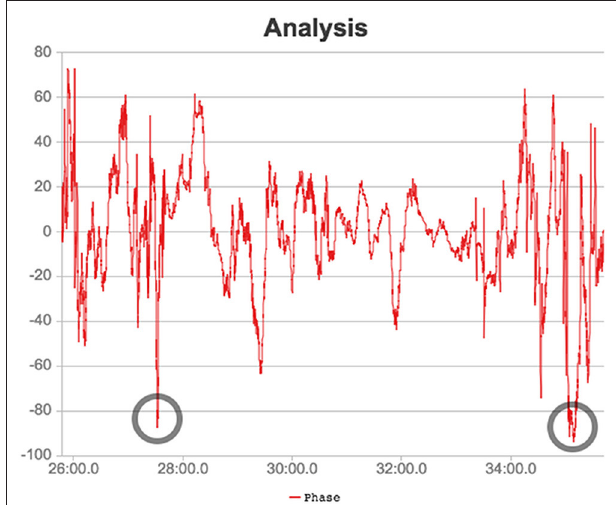
FIGURE 6 | Phase analysis for the two defenders between minutes 26 and 38 of the second half. The two lowest moments of coordination are rounded in the image.